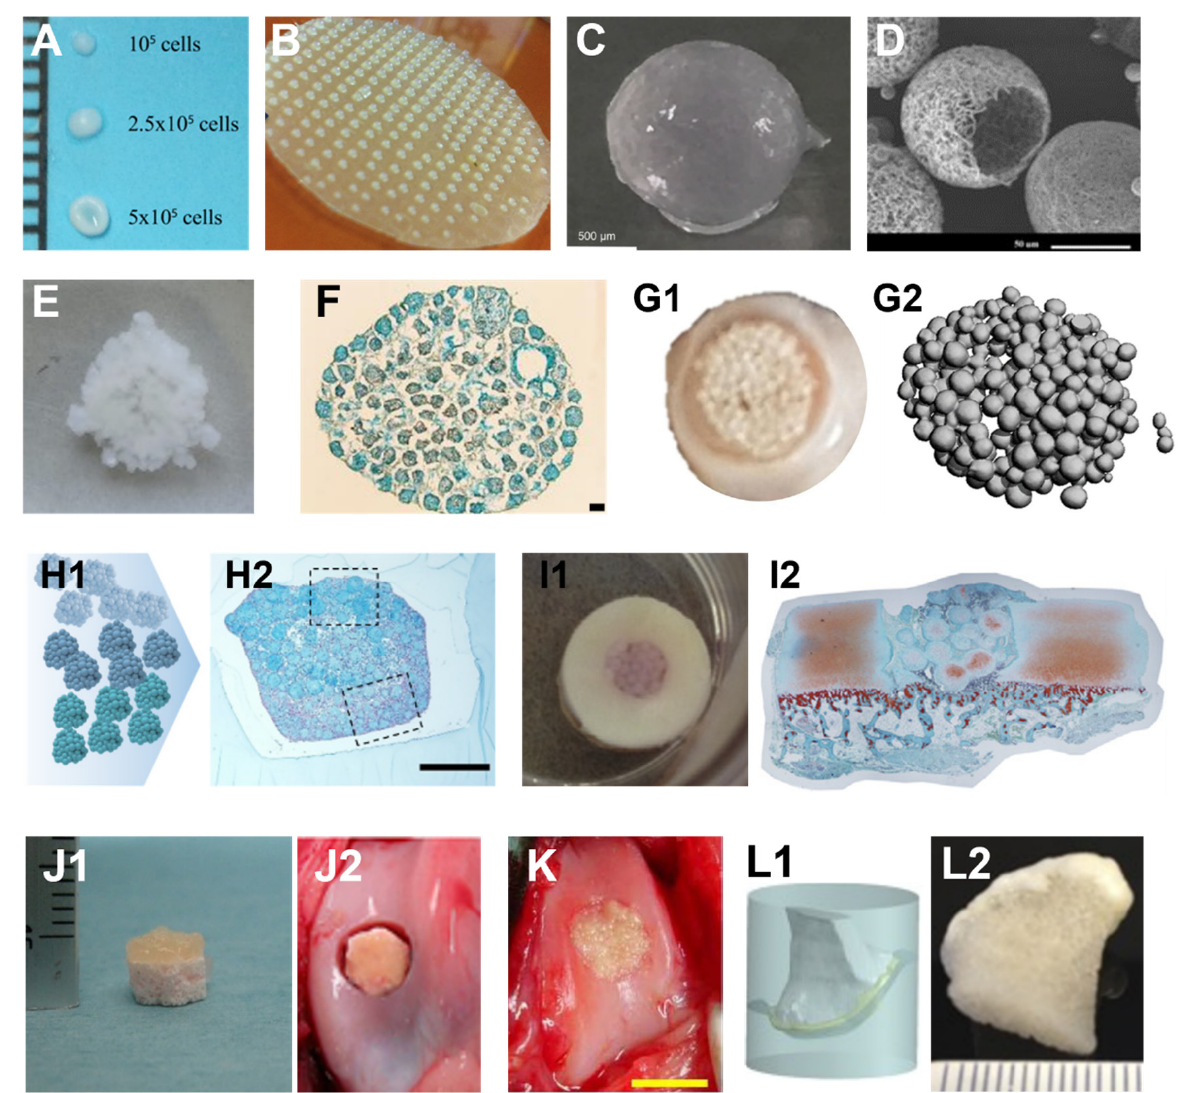
Figure 2. Examples of cartilage spherical building blocks generated and bioassembled using non- bioprinting methods. ( A ) Typical images of mesenchymal stem cell spheroids generated using the deep-well centrifugation methods. The number of cells per well affects the size and shape of a spheroid. ( B ) Microwell method and generated spheroids. ( C ) A hydrogel microsphere generated using alginate and chondrocytes. ( D ) An SEM image of nanofibrous polymer microsphere. ( E ) An assembled macro-tissue by bioassembling alginate/chondrocyte microspheres and individual micro- spheres are still visible. ( F ) A histological image of an assembled macro-tissue using chondrocyte spheroids. ( G ) A macroscopic image of chondrocyte spheroids after 8 weeks of manual bioassembly process in a well ( G1 ) and individual spheroids are still visible, shown by micro-CT imaging ( G2 ). ( H ) Spheroids generated using three different types of cells ( H1 ) can be fused together into a zonal structure ( H2 , histological staining) using the manual bioassembly method. ( I – K ) Examples of bioassembly in osteochondral defect repair. ( I ) Spheroids manual bioassembly in an in vitro osteochondral defect model ( I1 : macroscopic view; I2 : microscopic view of histological staining) ( J ) In vivo osteochondral defect repairing ( J2 ) using an osteochondral graft ( J1 ) generated by bioassembling cell-laden hydrogel microspheres on top of a bone-like scaffold or using only chondrocyte spheroids ( K ). ( L ) An example of anatomically shaped cartilage ( L2 ) generation using a custom-designed mold ( L1 ). Spheroids were placed on top of a pre-milled bone graft inside the mold (Figures adapted from